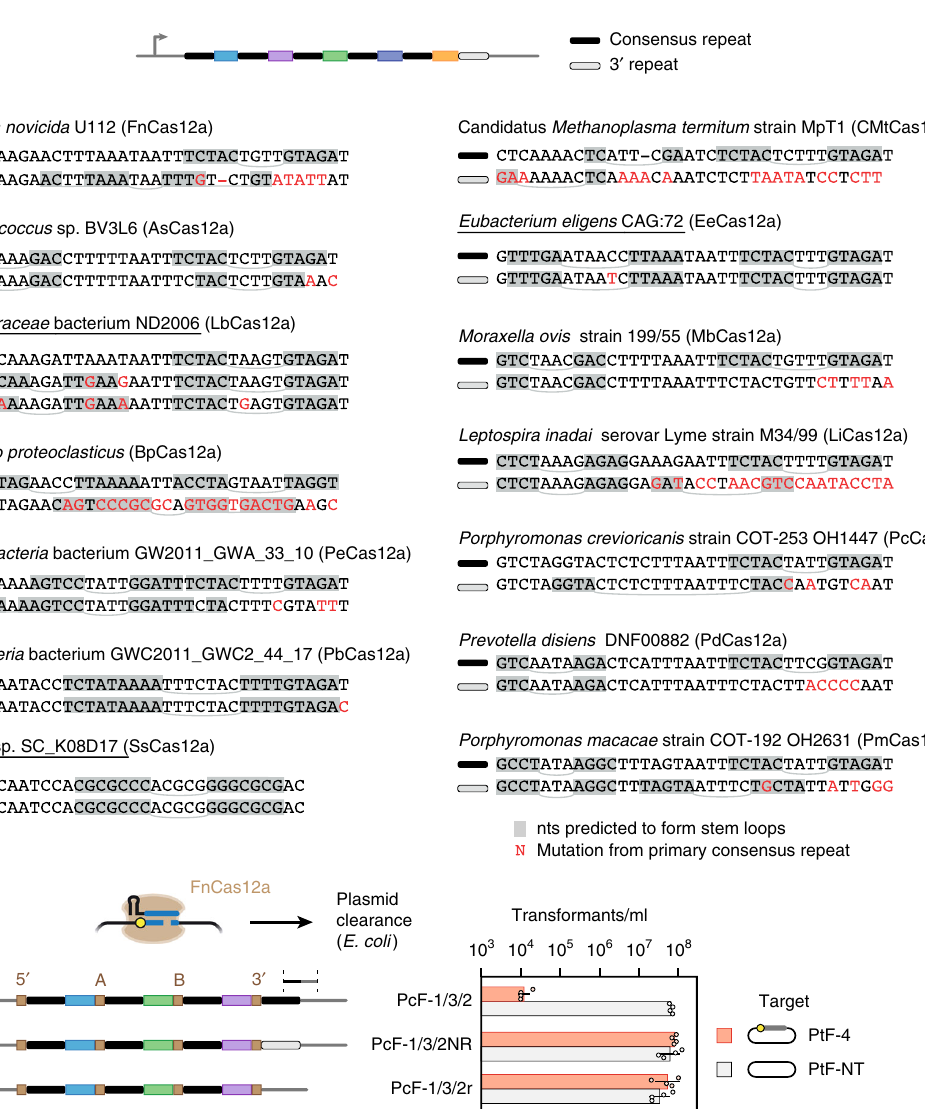
Fig. 7 The native terminal repeats in Cas12a arrays prevent DNA targeting by the extraneous crRNA. a CRISPR-Cas12a terminal repeats often contain mutations expected to disrupt crRNA processing. CRISPR arrays from Type V-A CRISPR systems in 14 different bacteria were evaluated. For each CRISPR array, the terminal repeat is compared to the consensus repeat. In one example ( Lachnospiraceae bacterium ND2006), two consensus sequences were present. Sequence deviations are highlighted in red, while base-paired stems predicted by NUPACK (http://www.nupack.org/) to form in the transcribed repeat are highlighted in gray. The thin gray lines show the loop (curved) or bulge (straight) of each predicted hairpin. Prior biochemical characterization of the repeat sequence revealed that the sequence and structure of the 3 ′ hairpin and the immediately upstream and downstream nts were critical for proper recognition and processing by Cas12a (refs. 15,58 ). Underlined strains harbor terminal repeats that are not obviously mutated to disrupt processing. b Assessing plasmid clearance through the extraneous crRNA in E. coli . The clearance assays were conducted as described in Fig. 3a using PcF-1/2/3 with a consensus 3 ′ repeat, a native terminal repeat, or no 3 ′ repeat. Values represent the geometric mean and S.D. of three independent transformation experiments starting from separate colonies. Source data are provided as a Source Data fi